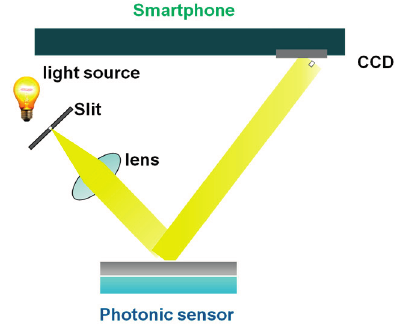
Figure 20. Our concept of a smartphone-based medical diagnosis system